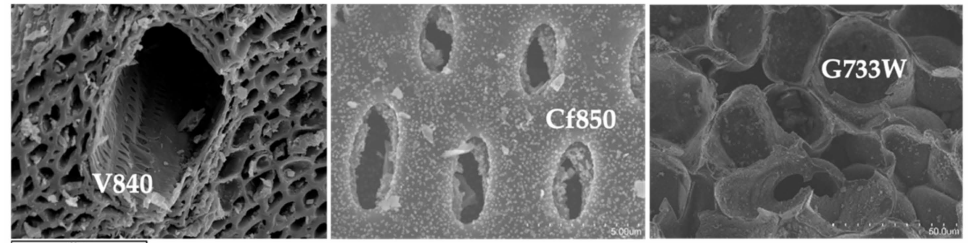
Figure 2. Representative SEM micrographs, samples V840, Cf850, and